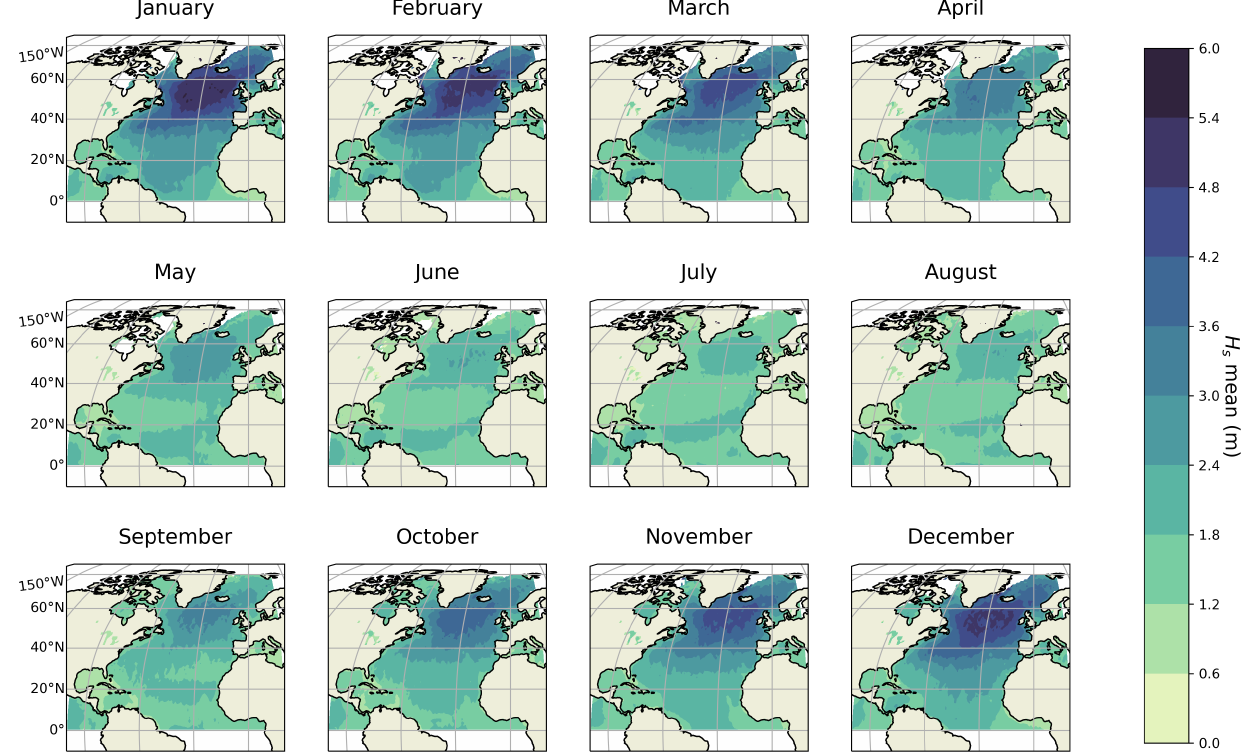
Figure 4. Maps of monthly mean of H s (m) calculated over the period 1993–2018 using altimeter